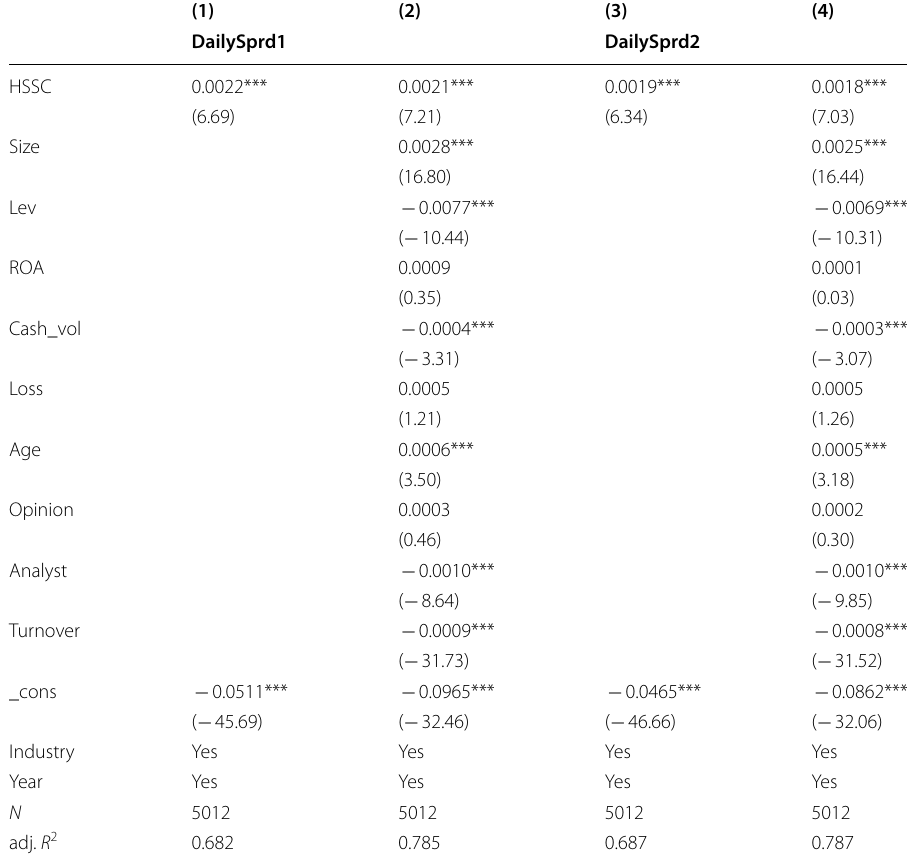
Table 6 Robustness checks: propensity-score matching